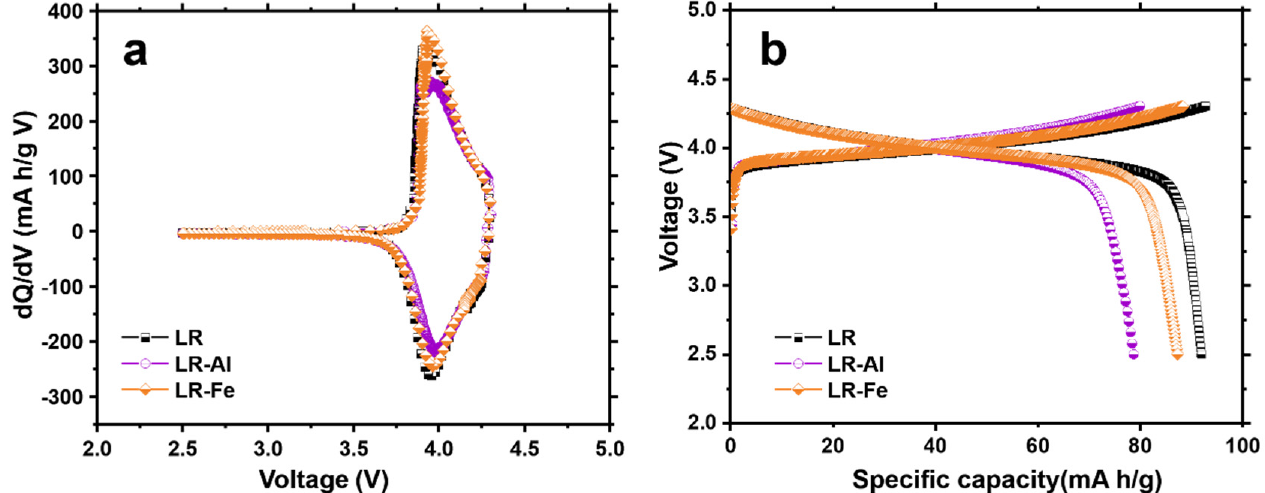
Figure 5. ( a ) dQ/dV plots and ( b ) the charge–discharge curves in the second cycle in the potential range of 2.5–4.3 V.